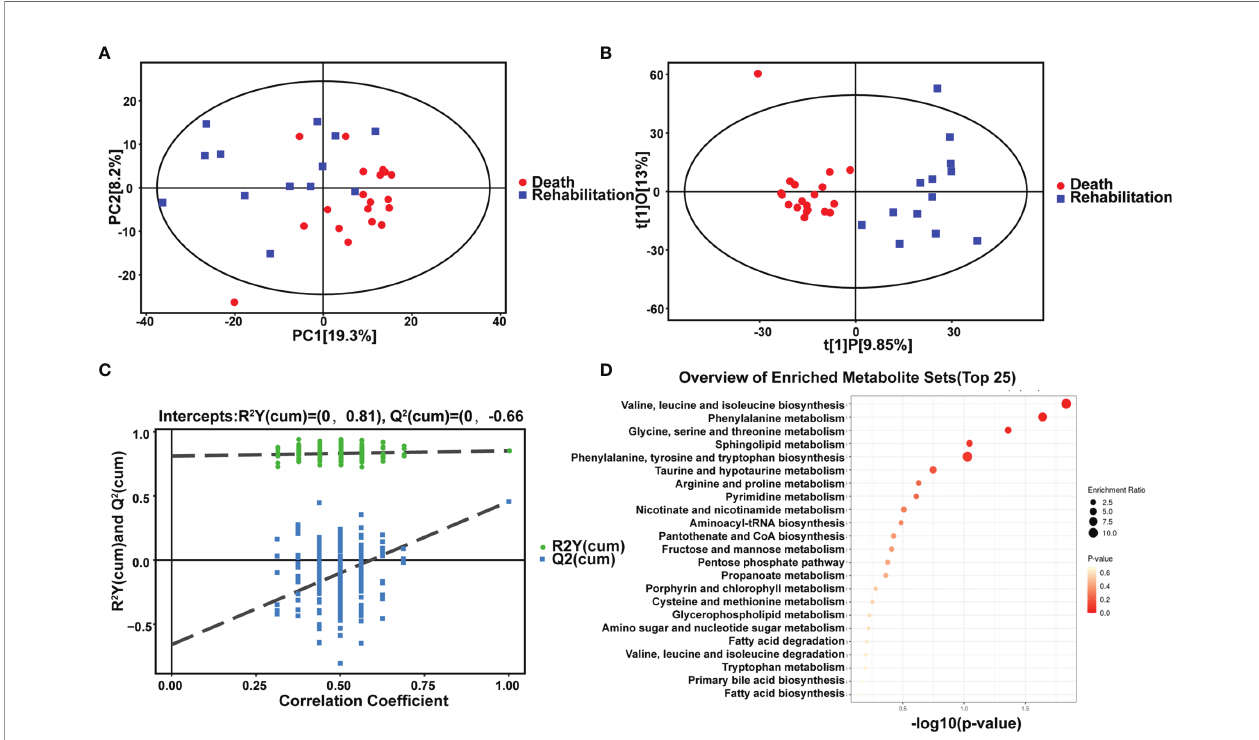
FIGURE 5 | Comparison of metabolic differences between rehabilitation and death. Metabolomic alternations and comparison of metabolic differences between rehabilitation and death in the critical group. (A) PCA analysis. (B) OPLS-DA analysis. (C) Permutation analysis. (D) Scatter plot of 13 differential metabolites with the most signi fi cant enrichment. p -value is plotted in a color map.